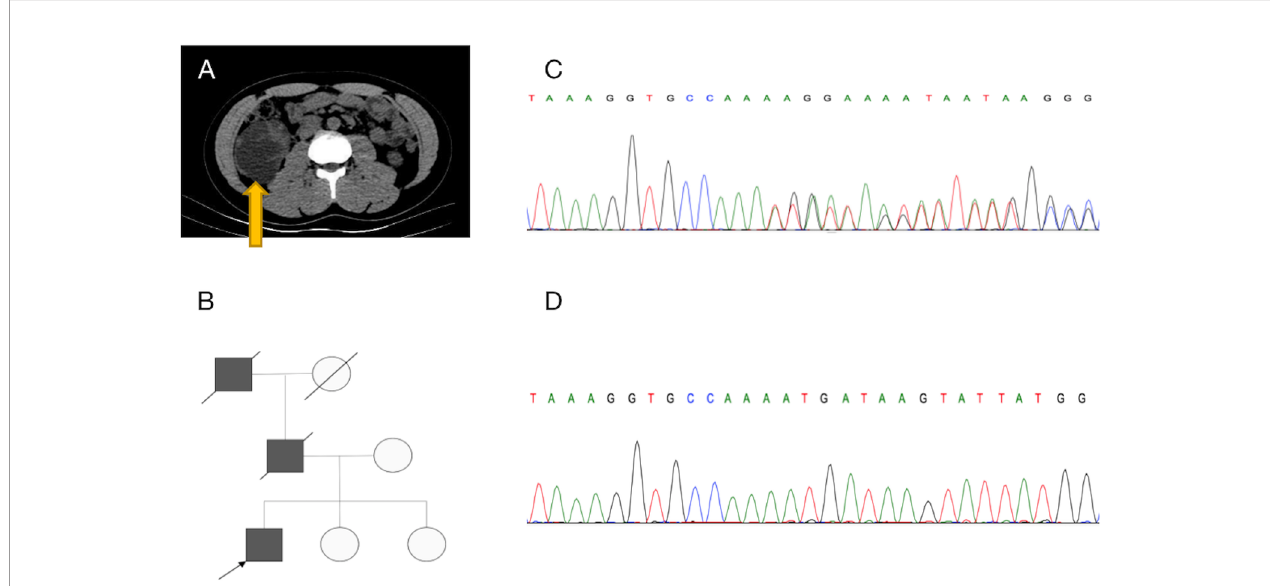
FIGURE 1 | Diagnosis of hereditary leiomyomatosis and renal cell cancer-associated renal cell carcinoma (HLRCC-RCC). (A) Transverse CT revealed a large mass in the lower middle part of the right kidney. (B) Pedigree of the family with three patients. The black symbols represent the affected members with renal carcinoma, and the arrow indicates the proband. (C, D) Genetic testing identi fi ed a novel fumarate hydratase (FH) germline mutation (c.191dupA:p.N64fs), which con fi rmed the diagnosis of HLRCC-RCC. (C) A heterozygous mutation was identi fi ed in blood, and (D) a homozygous mutation was identi fi ed in tumor